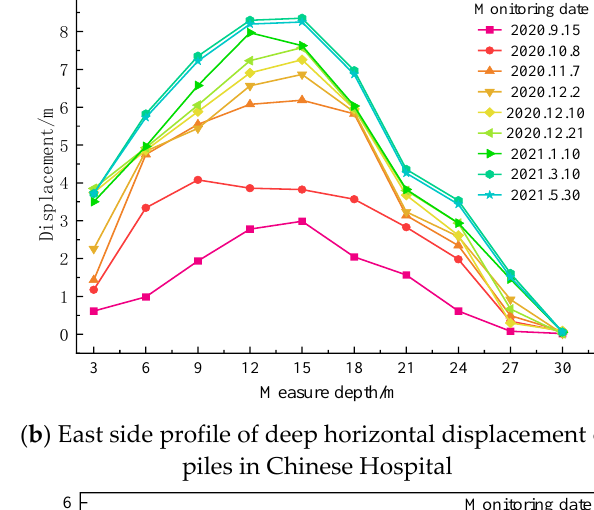
piles in Chinese Hospital